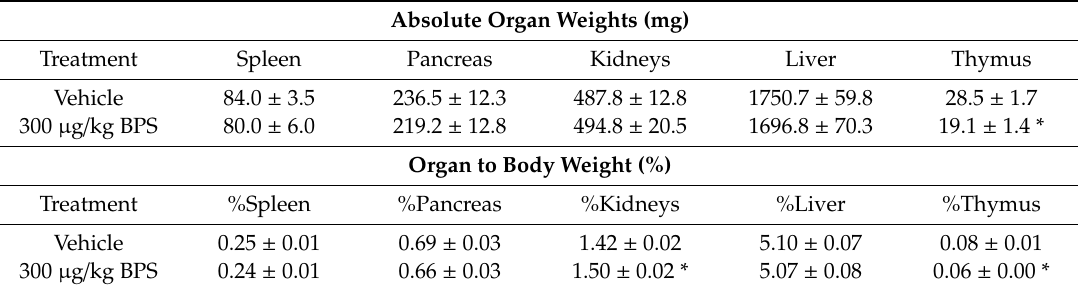
Table 4. Organ weights in male NOD mice initially on a phytoestrogen-free diet for 70 days and then switched to the soy-based diet for another 31